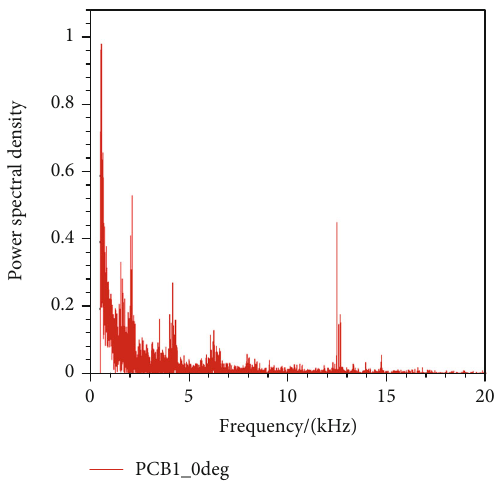
Figure 12: FFT frequency distribution of Test